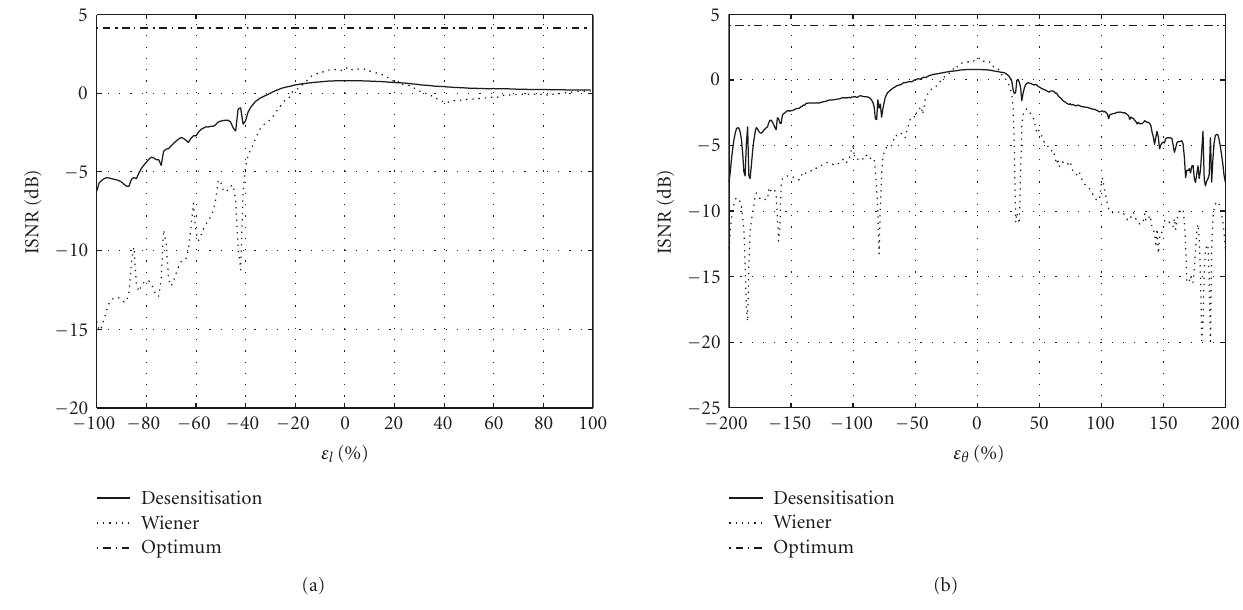
Figure 9: Distributions of ISNR obtained by both the Wiener filter and our desensitised method when the estimated parameters related to the PSF (motion blur) are altered, namely, the number of moved pixels (15 pixels) and the inclination (45 degrees) according to the errors ε ε l (a) and θ (b), respectively. Regarding noise, a Gaussian artefact is applied in relation to a BSNR of 20dB keeping the variance estimation unchanged. Besides, a horizontal line is included symbolizing the constant value of ISNR reached when optimum estimates are considered in the Wiener